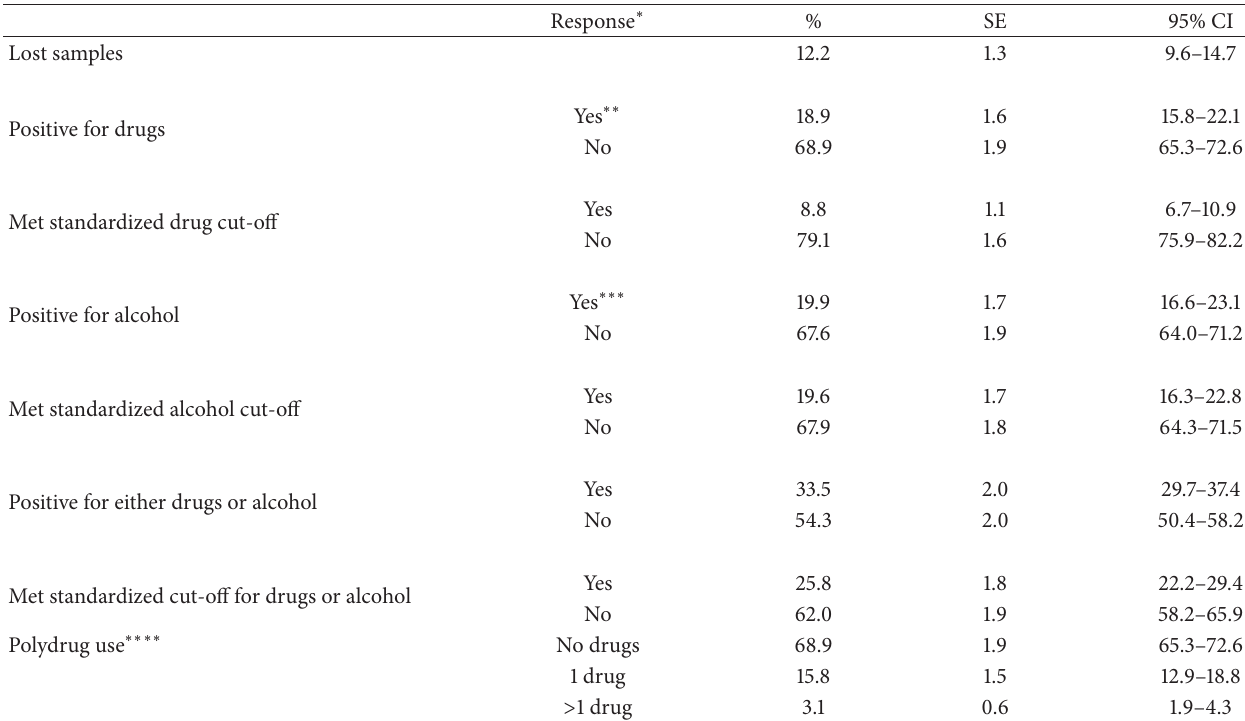
Table 5: Prevalence of alcohol and other drug use among the sub-sample (𝑛 = 684) :